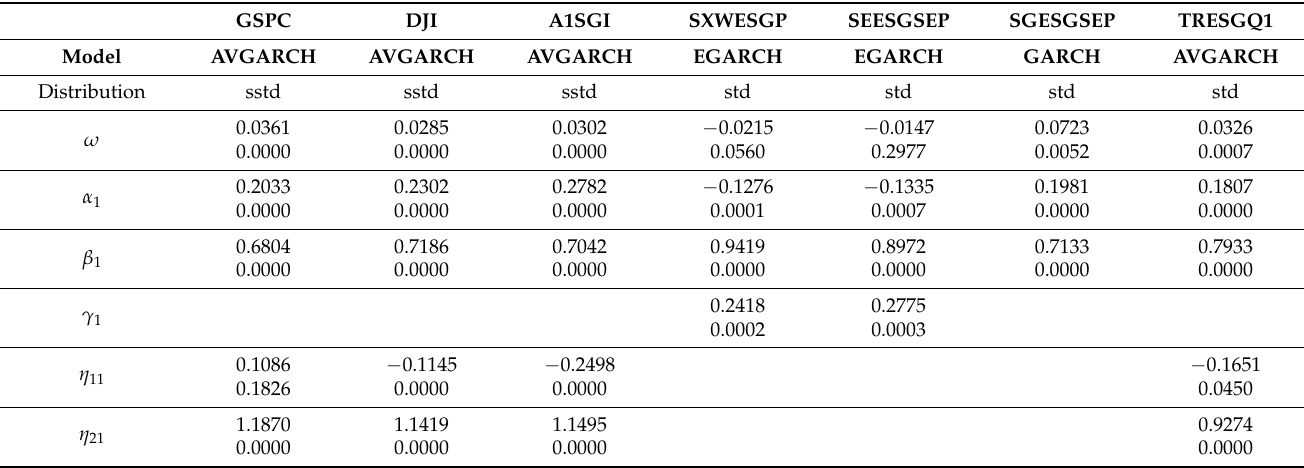
Table A4. Family GARCH models, 3 June 2014–31 January